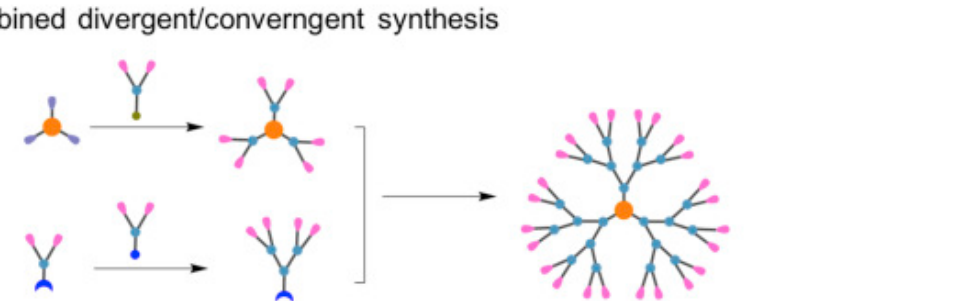
Figure 3. Covalent dendrimer synthesis using: ( A ) divergent synthetic route, ( B ) divergent synthetic route, ( C ) Combined approach (Adapted with permission from Lyu et al. [31]. Copyright (2019) Elsevier).